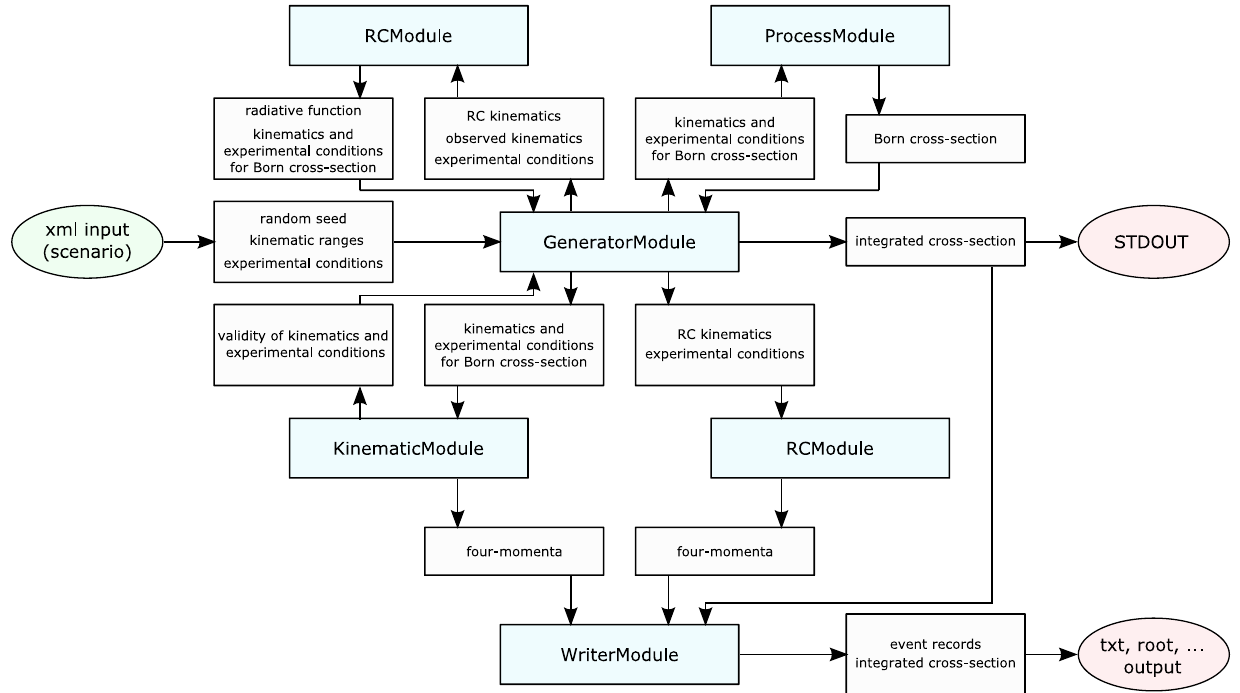
Fig. 2 Sketch showing the generic architecture of the project, i.e. without specifying the corresponding physics process for some modules. Details are provided in the text